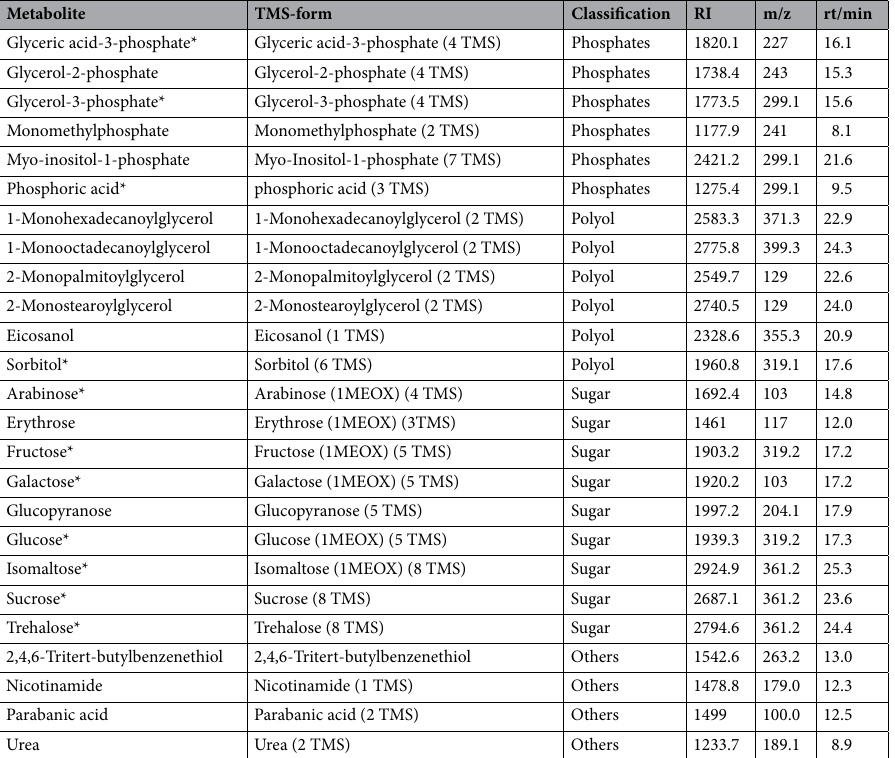
Table 1. Classification of identified metabolites. RI retention index, m/z mass to charge ratio, rt retention time. *Metabolites were identified by comparison of pure standard compounds and